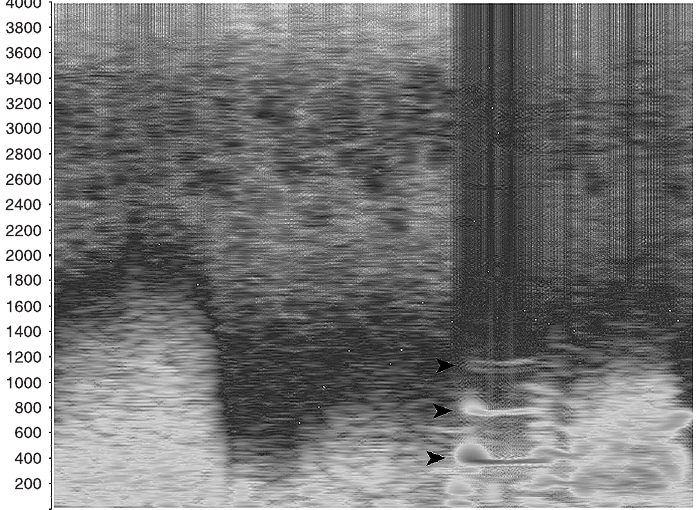
Figure 5. Spectrogram presented in Figure 2 after applying the Laplacian 9 x 9 mask. The appliance of this mask increases the contrast of horizontal lines, which is a characteristic to the presence of wheezes. The arrowheads indicate the wheezing signals, which have to be main- tained